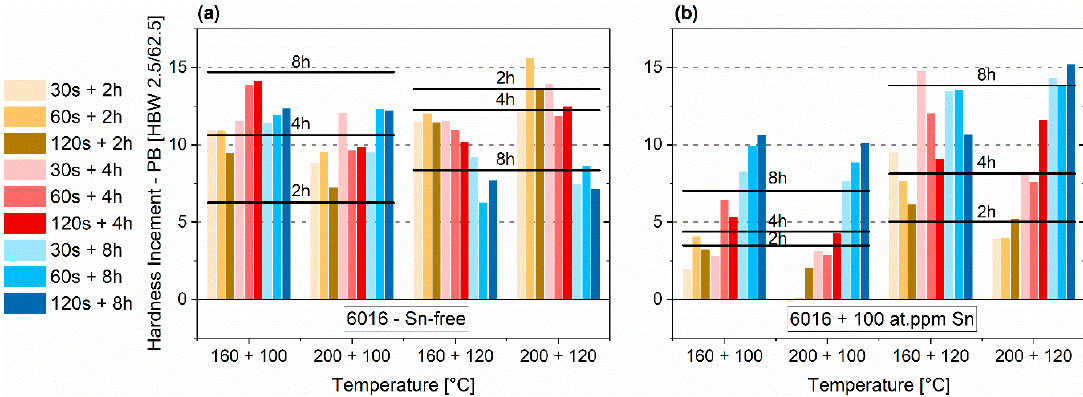
Figure 8. Paint-bake response (185 °C, 20 min, no pre-deformation) of samples treated according to PA2 (Spike I - first temperature in the axis label + PA - second temperature in the axis label) for EN-AW-6016 Sn-free ( a ) and EN-AW-6016 + 100 at.-ppm Sn ( b ). The horizontal black lines mark the paint-bake response of sole PA at 100 °C (left two column group) and at 120 °C (right two column group).